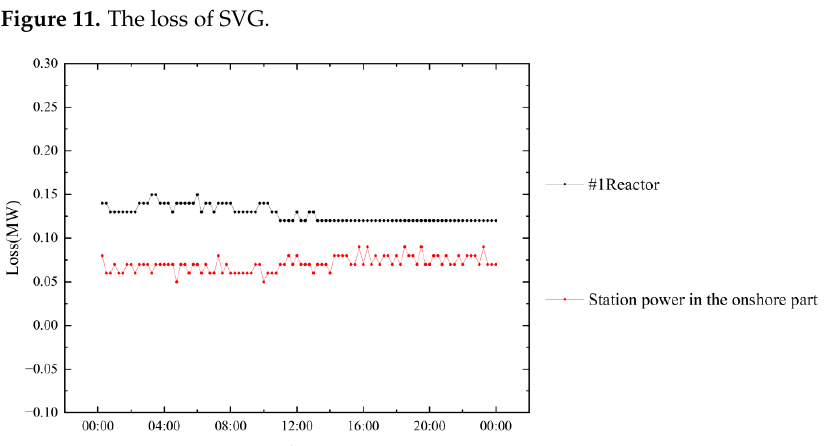
Figure 11. The loss of SVG.